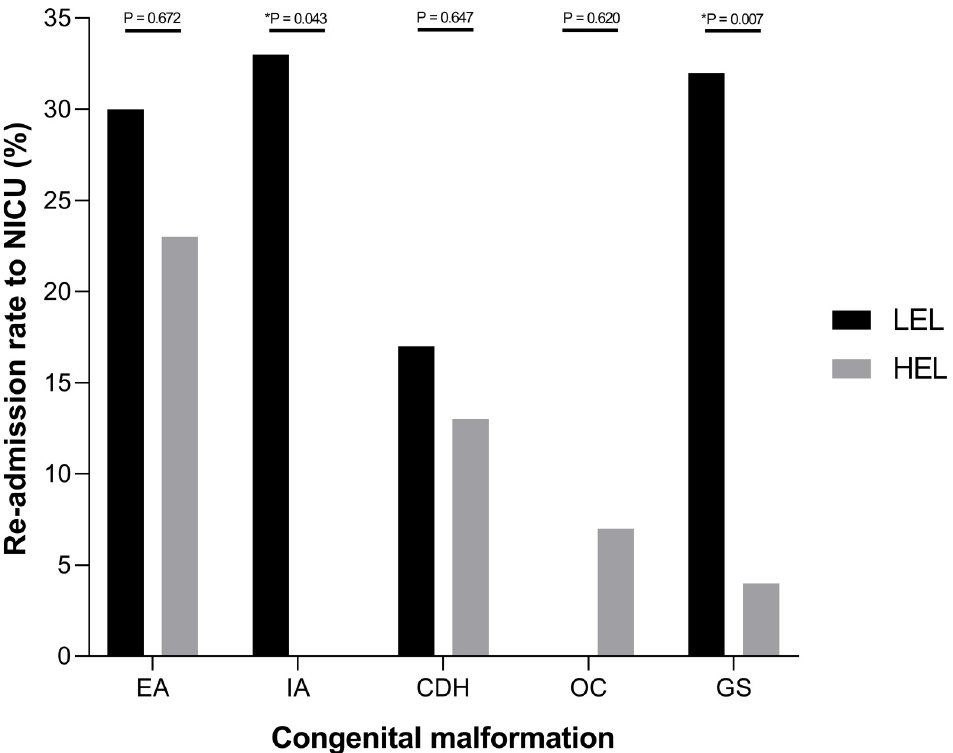
Fig 2. Re-admission rate to NICU. Percentage stratified for the different patient groups, P-values were determined by Student’s t -test.